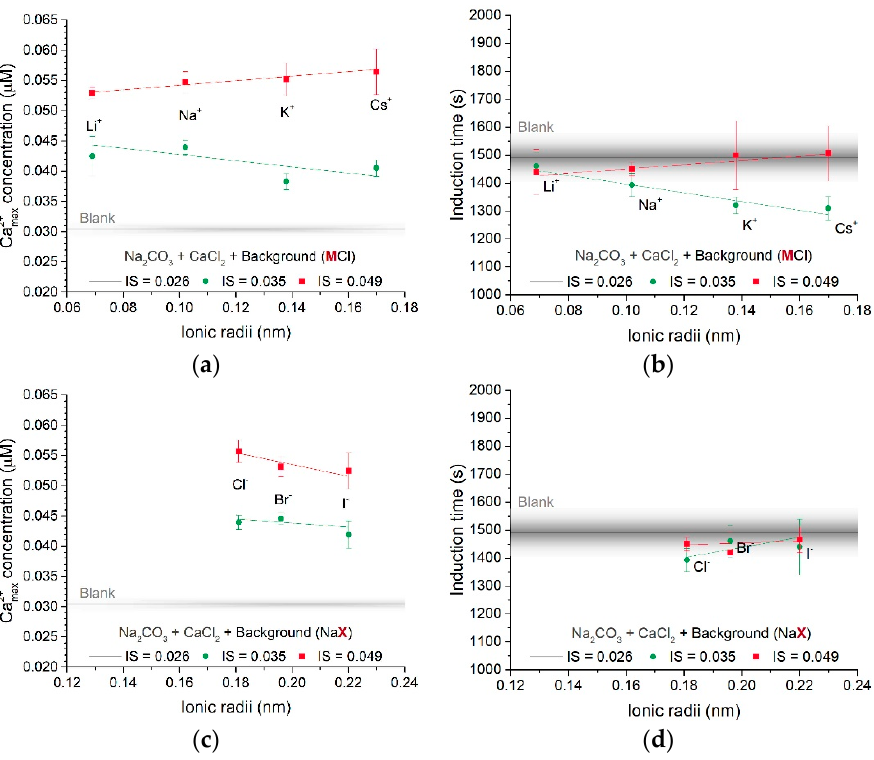
Figure 6. Maximum free Ca 2+ concentration and elapsed time before the onset of CaCO 3 precipitation for type II experiments. CaCl 2 was used as titrant, and Na 2 CO 3 as carbonate source in the reactor together with different external background salts ( a , b ) using different chloride salts, ( c , d ) using different sodium salts. Two different background electrolyte concentrations (10 mM and 25 mM) were used, increasing the ionic strength (IS) to 0.035 (green lines) and 0.049 (red lines), respectively. Errors bars show 2 σ N . The blank black line and grey band show the average value and 2 σ N , respectively, from titration experiments without any external background salt.